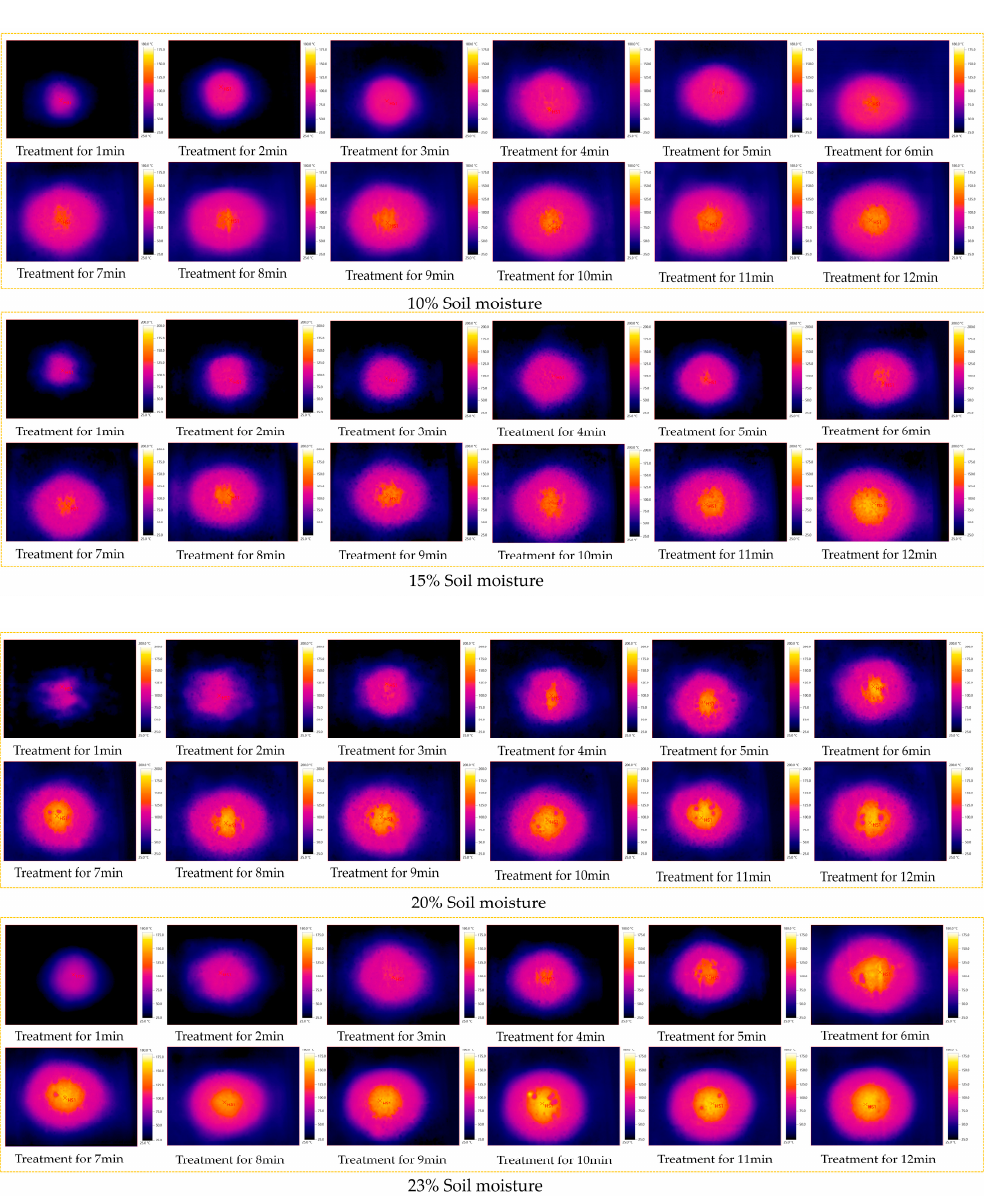
Figure 12. Thermal image of the surface of water-bearing black soil irradiated by microwaves.